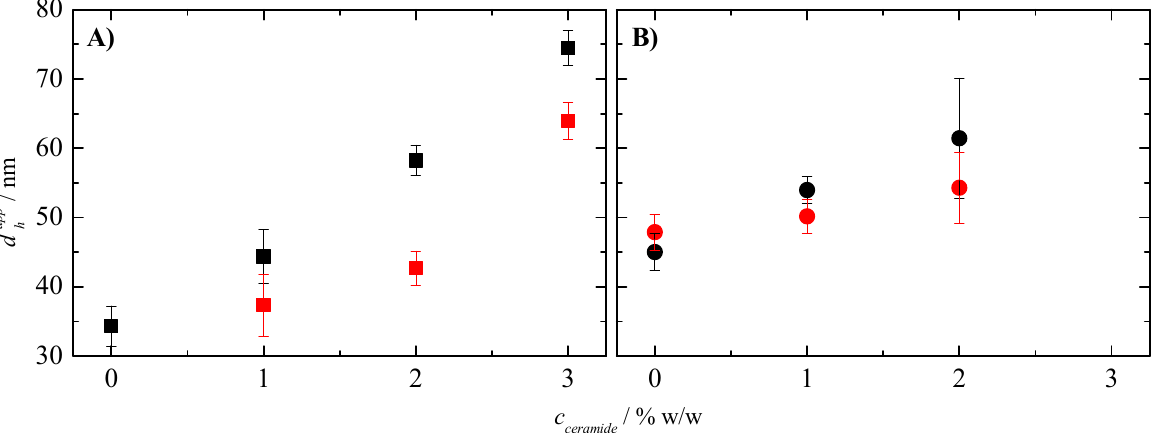
Figure 5. Dependence of apparent hydrodynamic diameter on the concentration of solubilized ceramide in the microemulsions obtained from DLS experiments. ( A ) O/W microemulsions with oleic acid in the oil phase and Akypo/2-propanol of a 1/2 ratio with a total concentration of the emulsifier mixture of ( ■) 43% w / w and ( ■) 44% w / w . ( B ) O/W microemulsions with soybean in the oil phase and Akypo/2-propanol of a 1/2 ratio with a total concentration of the emulsifier mixture of ( ● ) 43% w / w and ( ● ) 44% w / w . The oil content in all the dispersions was 3% w / w .